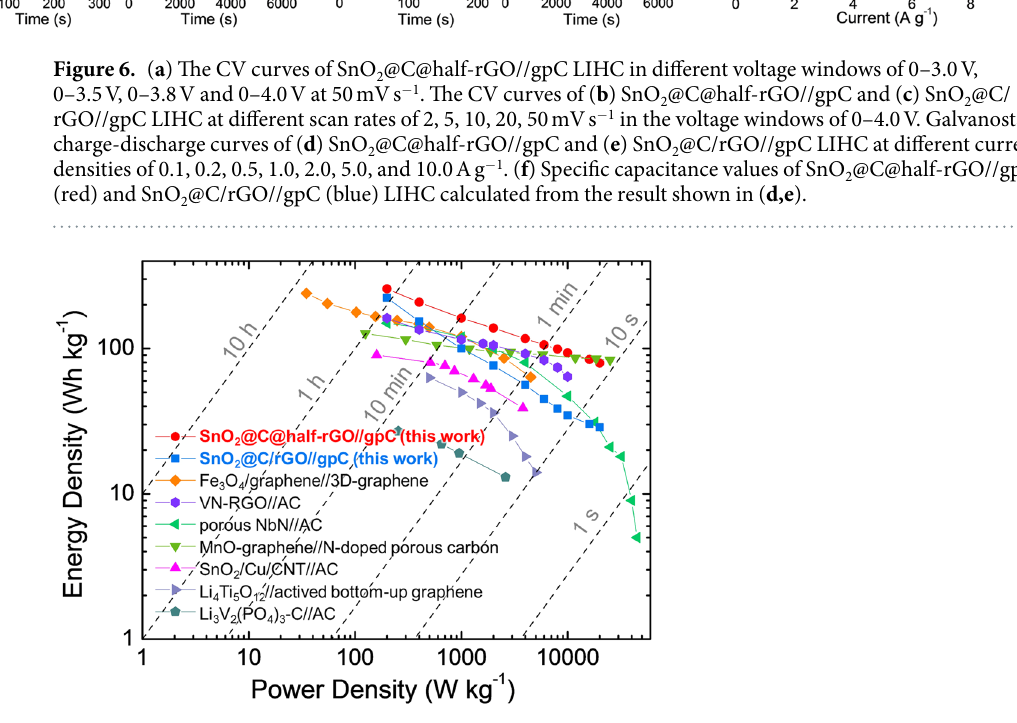
Figure 7. Ragone chart of SnO 2 @C@half-rGO//gpC and SnO 2 @C/rGO//gpC. The performance is compared with reported similar LIHC systems including Fe 3 O 4 /graphene//3D-graphene 32 , VN-RGO//AC 33 , porous NbN//AC 34 , MnO@graphene//HNC 35 , SnO 2 /Cu/CNT//AC 36 , Li 4 Ti 5 O 12 //activated bottom-up graphene 37 , and Li 3 V 2 (PO 4 ) 3 -C//AC 38